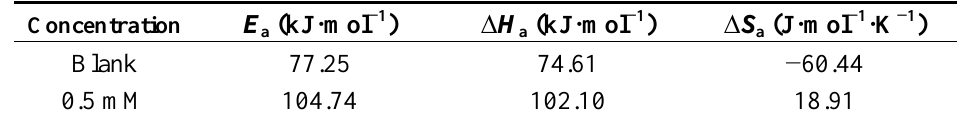
Table 3. Corrosion kinetic parameters for mild steel in 1.0 M HCl in the presence and absence of